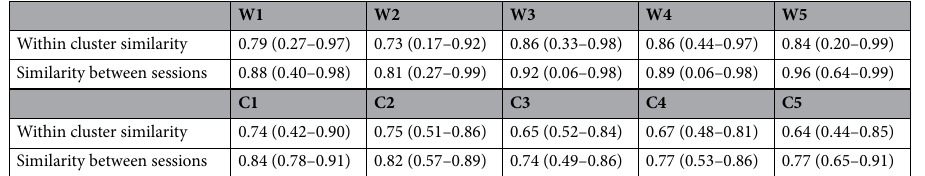
Table 1. Summary of the results for the intra-cluster similarity and inter-session similarity of muscle synergy (W) and temporal activation (C). Each value is provided as a mean and the